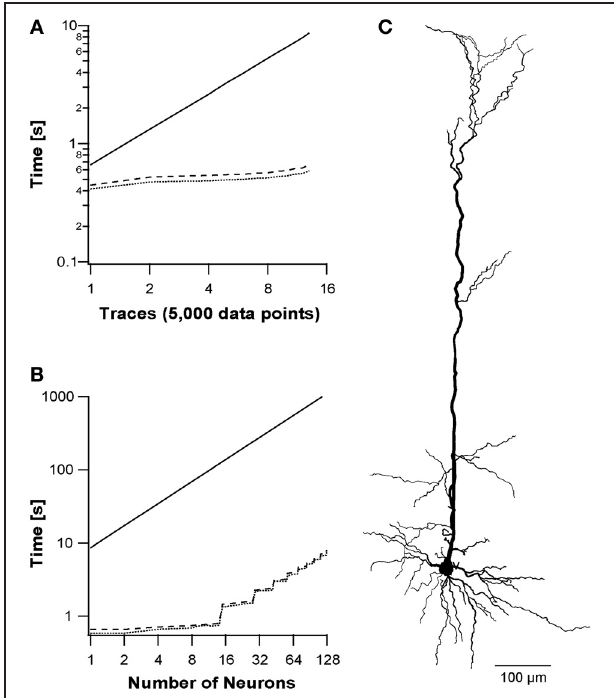
FIGURE 5 | Simulation of multiple sweep protocol and multiple neurons. A simulation protocol using reconstructed pyramidal neuron morphology with 112 branches (C) and a varying number of sweeps, where each sweep included 5000 data points. (A) Run times of increasing number of sweeps using three simulations: NEURON simulation (solid line); segment-based parallelization (dotted line); branching-based parallelization (dashed line). The y-axis shows the runtime on a log scale. (B) Run times of the three simulations on multiple neurons, where each neuron consists 13 traces (65,000 data points) as described in (A)